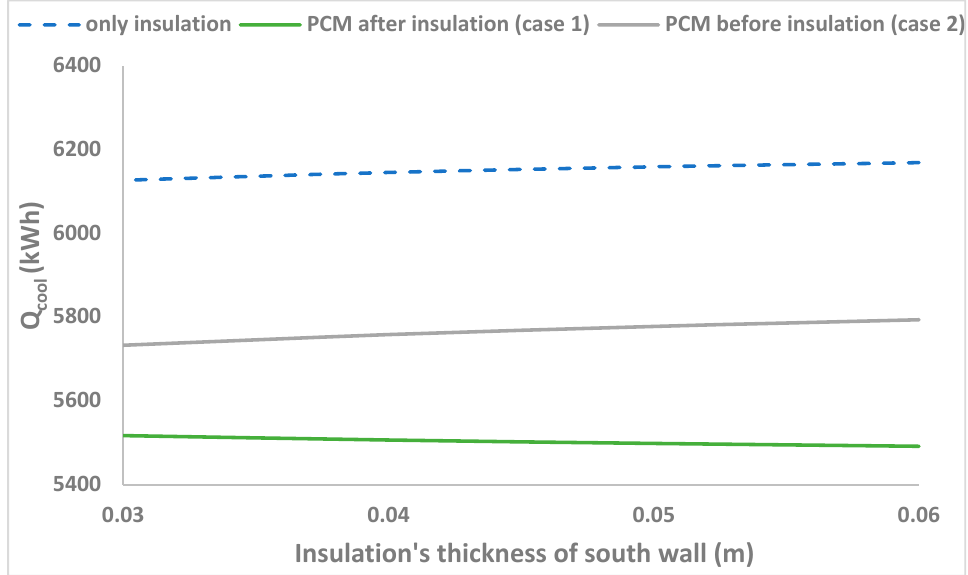
Figure 7. Annual cooling loads with PCM in south wall for different insulation scenarios.